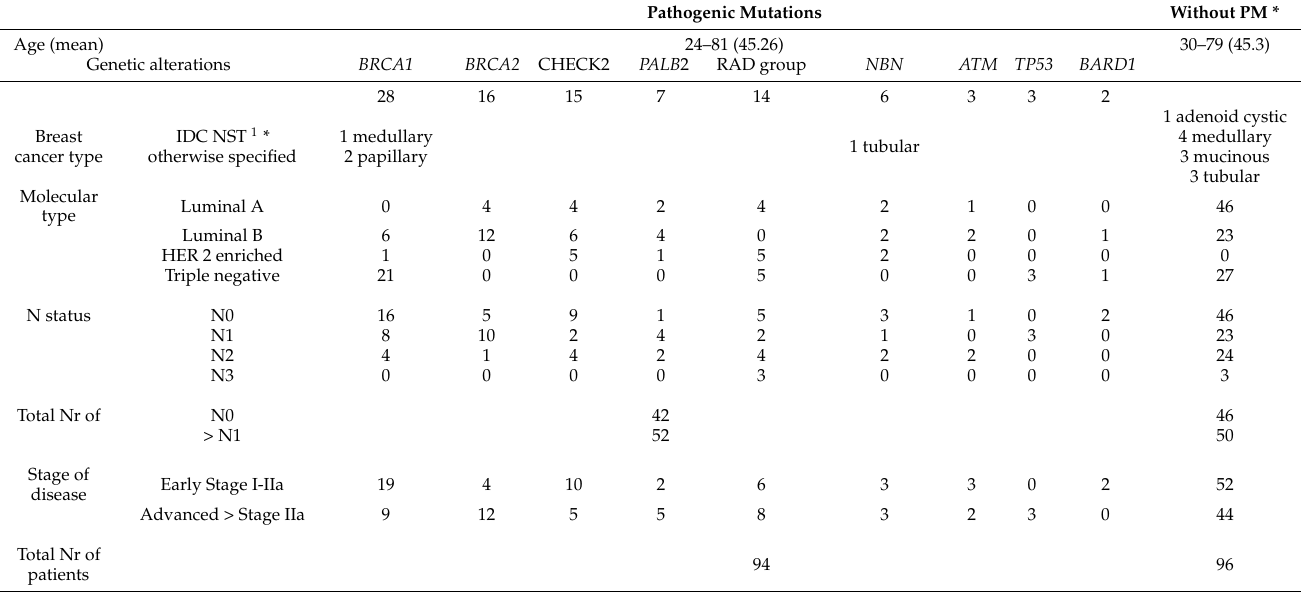
Table 1. Genetic testing and pathology results for study population.